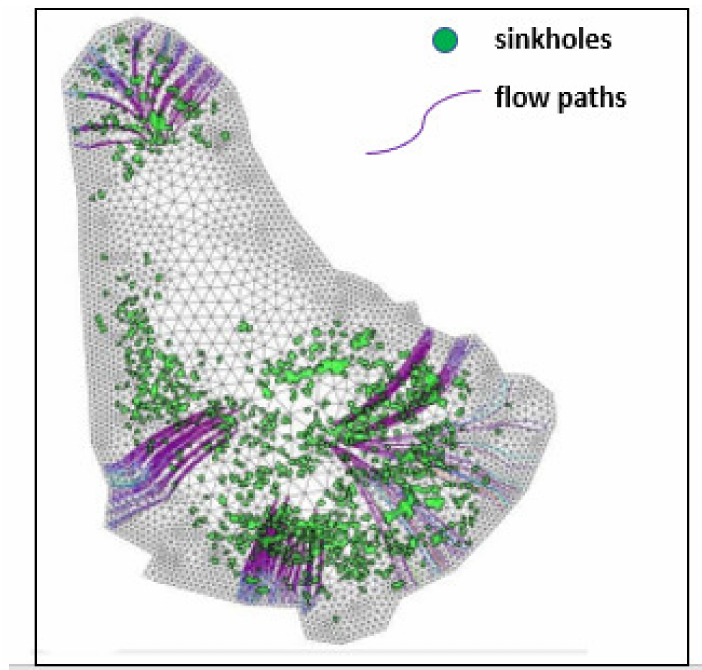
Figure 7. Regional groundwater flow paths (purple lines) predicted by the model. The filled green polygons are the locations of sinkholes across the